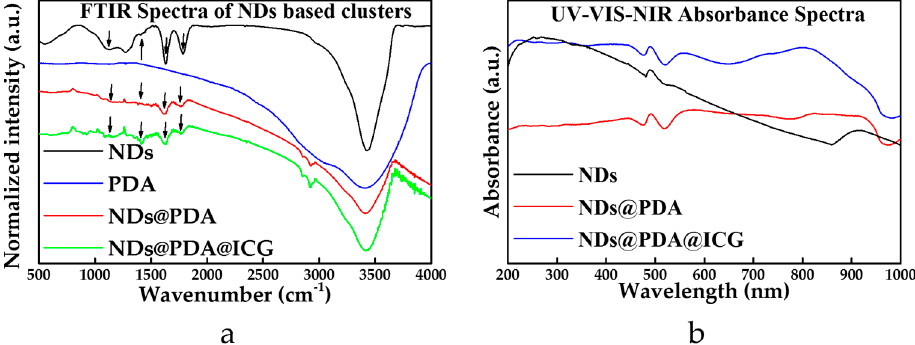
Figure 2. ( a ) FTIR spectra of NDs (black), PDA (blue), NDs@PDA (red), and NDs@PDA@ICG (green). Arrows indicate the characteristic bands in PDA and NDs, allowing assessment of a successful functionalization process. ( b ) UV–Vis–NIR absorbance spectra of NDs (black), NDs@PDA (red), and NDs@PDA@ICG (blue). The NDs@PDA@ICG exhibits the highest absorption for NIR irradiation (797 nm). a.u.: Arbitrary units.